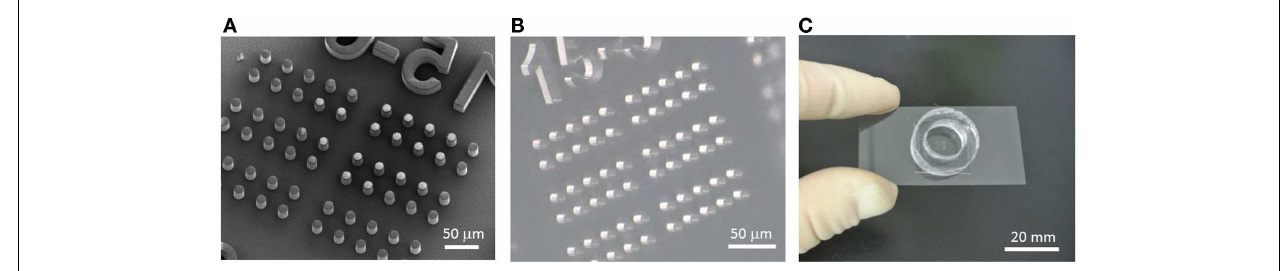
FIGURE 2 | Fabrication process of the microchamber device . (A) SEM image of the SU-8 master mold formed on a silicon wafer. (B) PDMS microchamber device removed from the mold. (C) Microchamber device with the ring structure used to retain the buffer and reagents.This setup is mounted on the microscope stage for